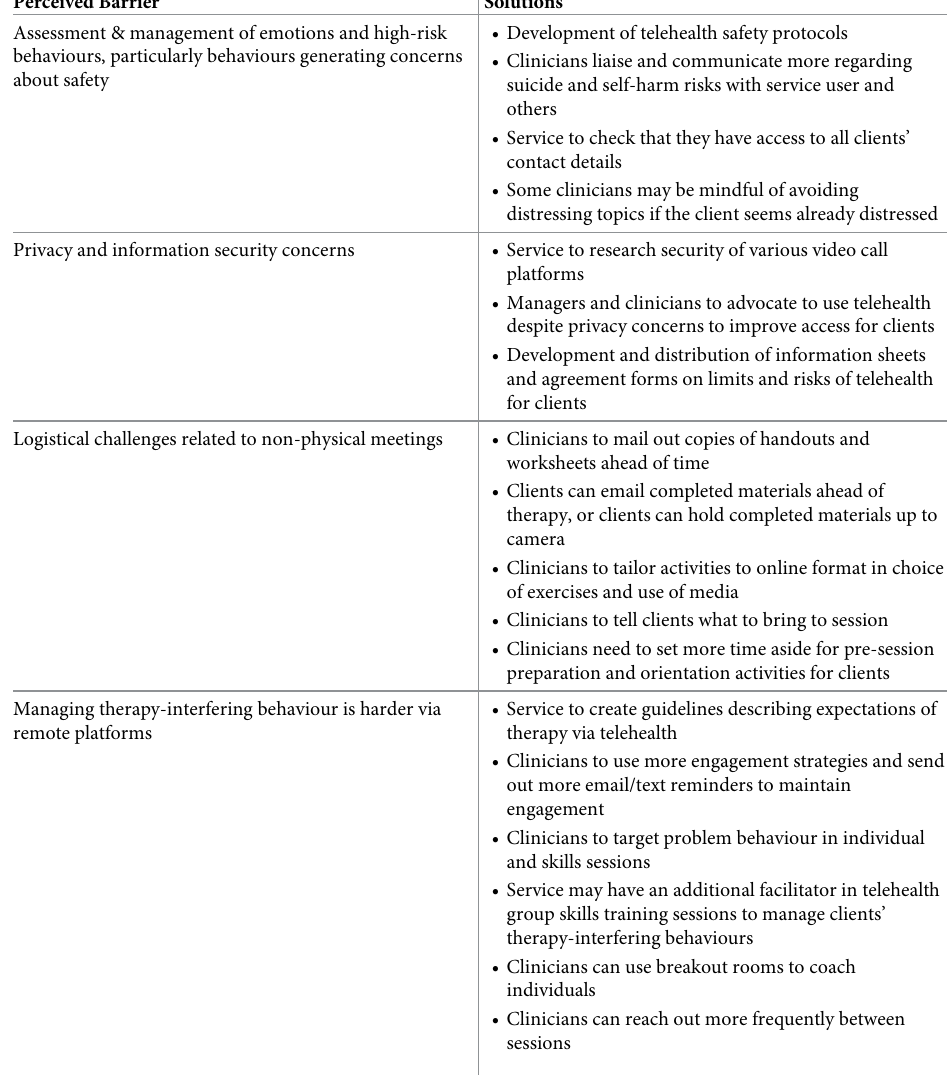
Table 2. Perceived barriers for therapists in delivering DBT via telehealth, and associated